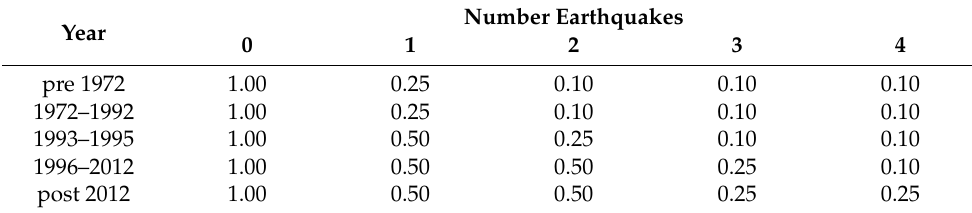
Table 5. Factor B for masonry buildings.